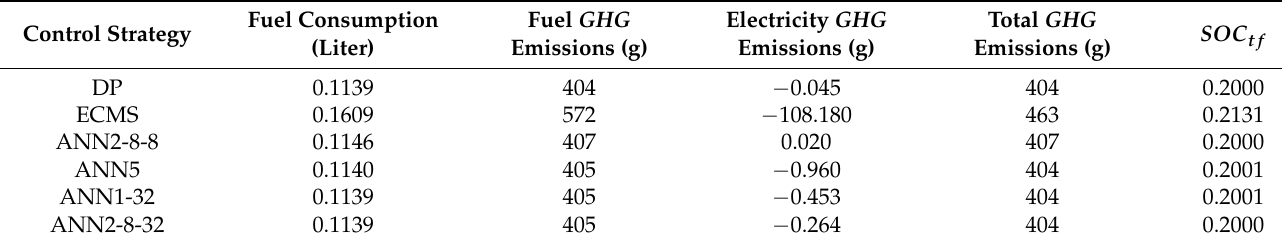
Figure 10. SOC results for NYCC-LD drive cycle. Table 5. NYCC-LD results